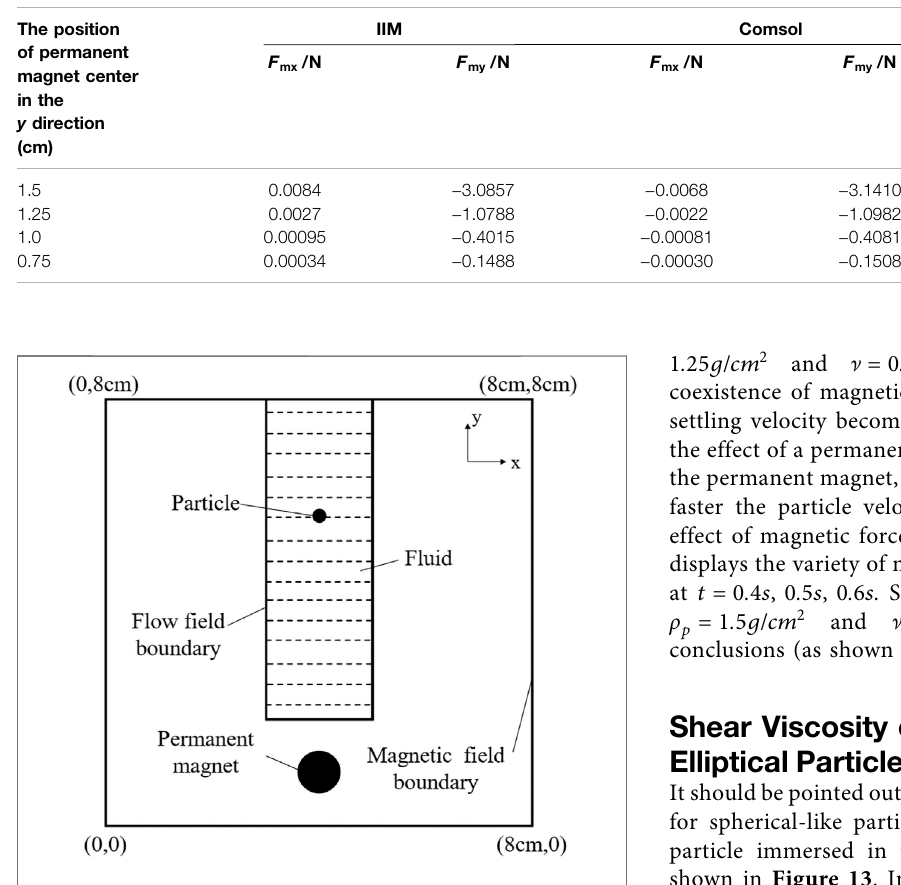
FIGURE 9 | Model of particle sedimentation under the action of permanent magnet.